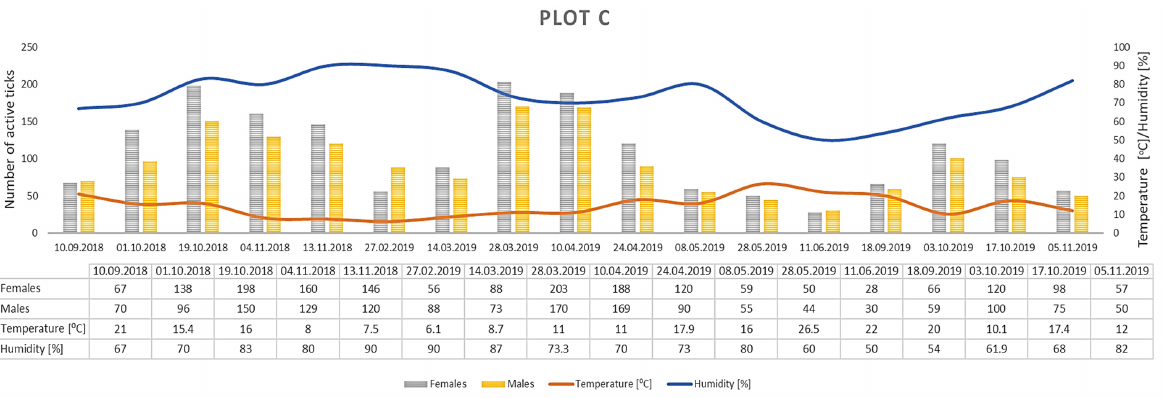
Figure 4. Abundance and seasonal activity of Dermacentor reticulatus adults in research plot B and weather conditions prevailing during tick collection. Predominance of active ticks in autumn.